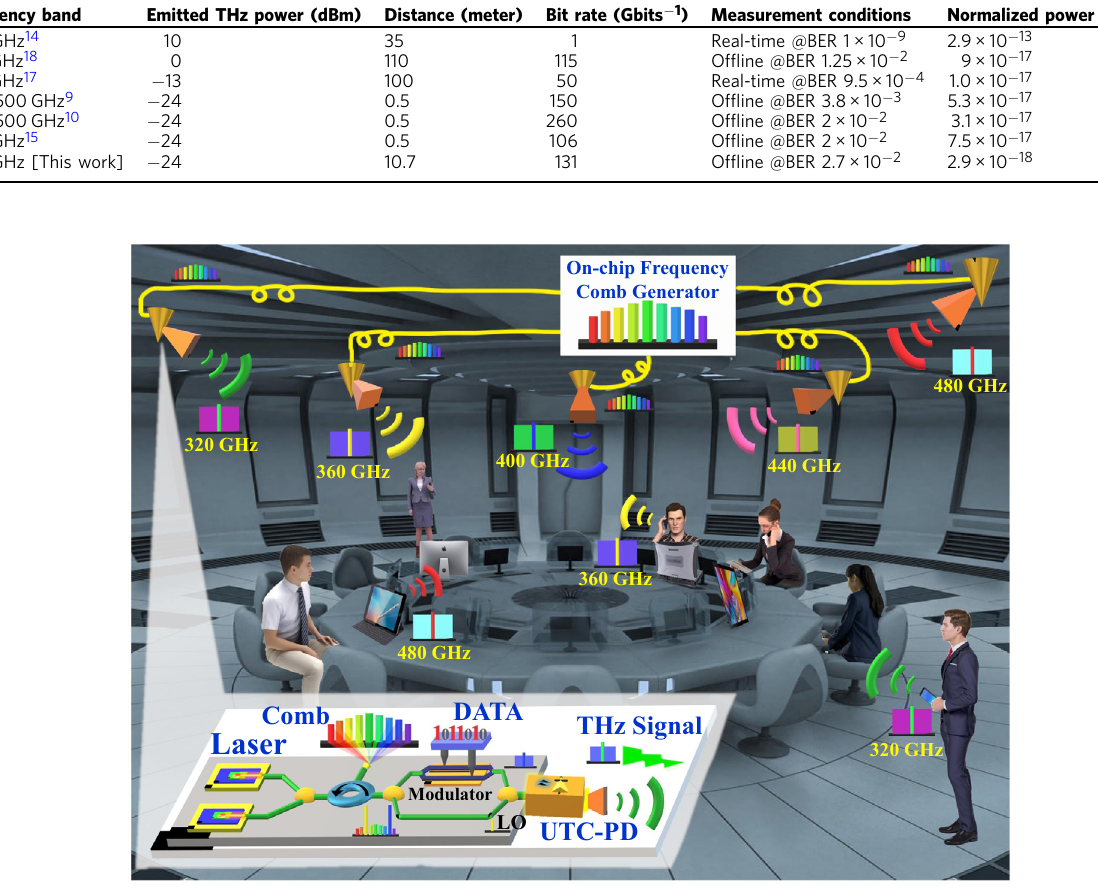
Fig. 2 A conceptual diagram of a high-speed wireless local area network (WLAN) based on THz frequency division multiplexing (FDM) with fully integrated on-chip THz transmitters injection-locked by a optical frequency comb (OFC). The shared frequency comb is distributed to each integrated THz transmitter, consisting of dual-DFB lasers, data modulator, UTC-PD, and THz antenna. LO local oscillator; UTC-PD uni-traveling carrier